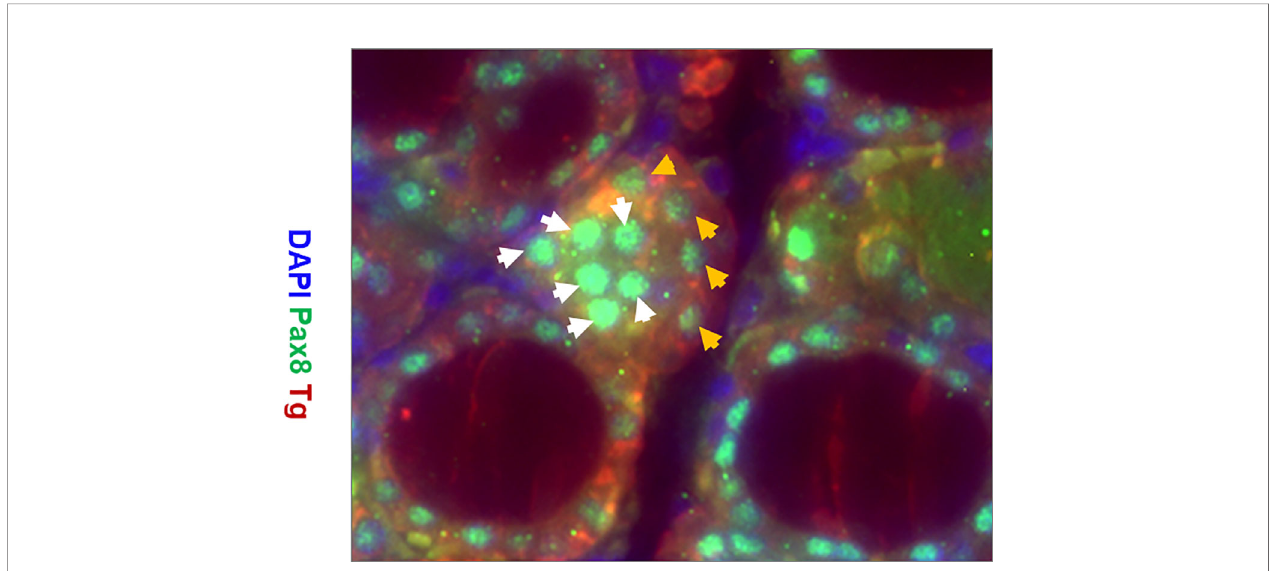
FIGURE 7 | Representative images of immunostaining for expression of Tg (red), Pax8 (green), and DAPI (blue) in the thyroid gland of TPOCreER2/iDTR mice injected with TM/DT for 2 weeks. Note the larger parafollicular collections of cells positive for Pax8 (green) and negative for Tg (labeled with white arrows) indicative of progenitor cells and Pax 8 positive and Tg positive cells (labelled with orange arrows) indicative of more mature cells. There are also Pax8 and Tg negative cells (blue) which are likely fi broblast or other cell